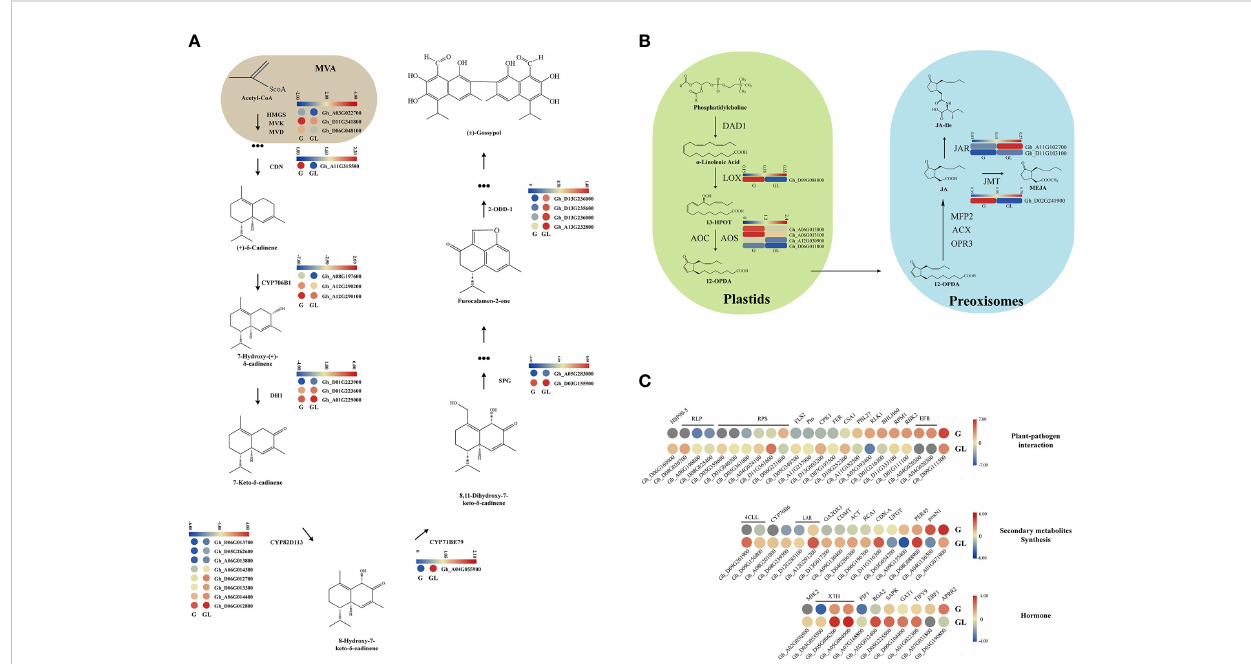
FIGURE 7 Heatmap of the differentially expressed genes assigned to gossypol biosynthetic and jasmonic acid biosynthetic pathways. (A) The gray part was MVA pathway, the other part was the gossypol biosynthetic pathway. (B) The jasmonic acid biosynthetic pathway, which were in the plastid and deoxyridisome, respectively. (C) The differentially expressed genes were involved in plant pathogen interaction, secondary metabolic synthesis and hormone synthesis. Only the differentially expressed genes in gossypol and non-gossypol materials were shown in the fi gure. The genes in the red box were upregulated without treatment, and the blue solid line were downregulated. G, glandular cotton; GL, glandless cotton; HMGS, hydroxymethylglutaryl-CoA synthase; MVD, mevalonate 5-diphosphate decarboxylase; MVK, mevalonate kinase; CDN, (+)- d -cadinene synthase; DH, short-chain alcohol dehydrogenase; SPG, specialized glyoxalase; 2-ODD, 2-oxoglutarate/Fe (II)-dependent